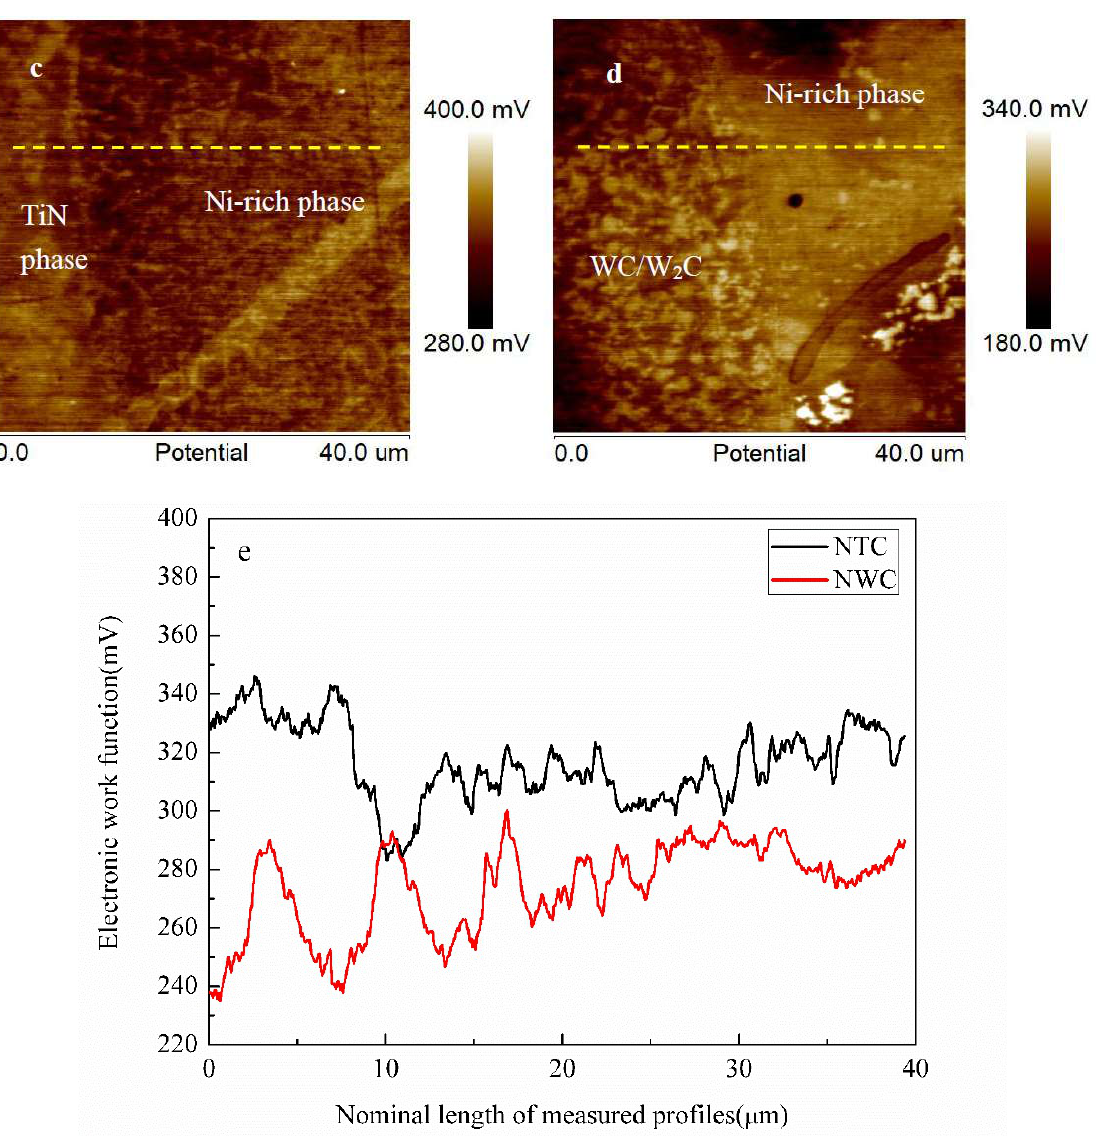
Figure 5. AFM images of the cross-sections of: ( a,c ) NTC coating, and ( b,d ) NWC coating. ( e ) EWF line profiles of coatings corresponding to the dashed lines in Figure 5 c , d .